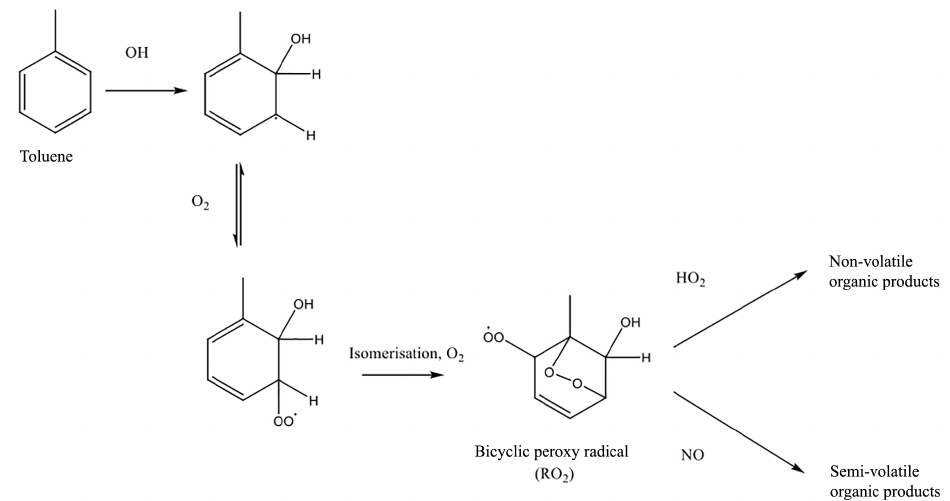
Figure 1. Formation of lower volatility vapours from toluene photooxidation, as described in Ng et al. (2007).